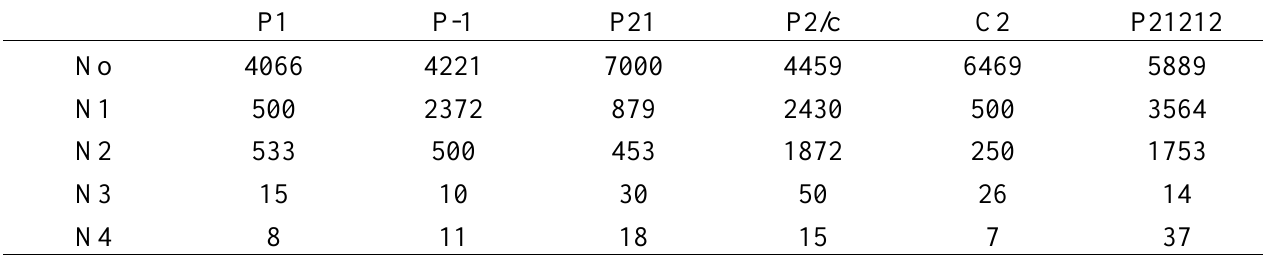
Table I. The results of search of crystal structures [32] of L-ascorbic acid